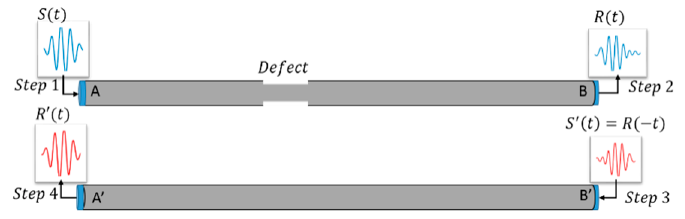
Figure 3. Steel time reversal detecting system.